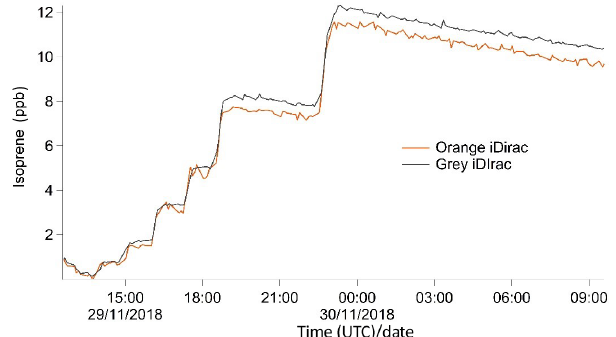
Figure 8. Summary plot of a concentration determination experi- ment. The primary reference gas mixture is used as the standard in the calibration runs, and the secondary gas mixture under test is used as the sample.